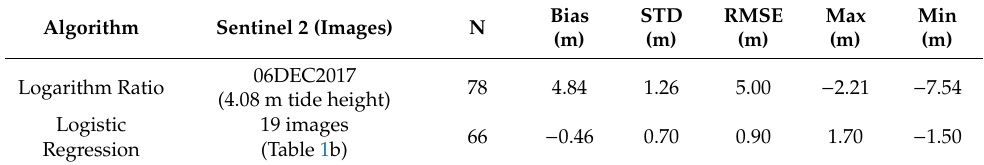
Table 4. Statistical analysis of di ff erences between chart depths in the Bijag ó s archipelago and